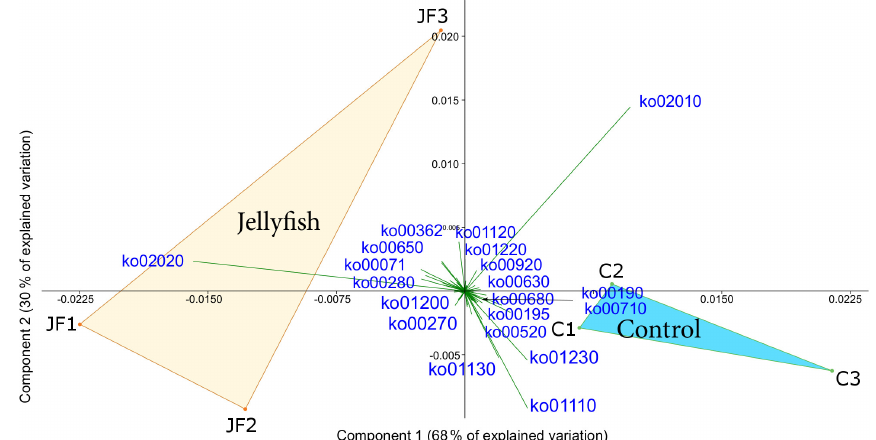
Figure 8. Principle component analysis biplot of functional diversity based on taxonomy-based functional predictions using Tax4Fun2. JF indicates jellyfish samples; C indicates control samples. The vectors present KEGG pathways. The within-group similarity is 95% between the jellyfish treatments (red) and 97% between the controls (light blue). The following KEGG pathways are shown: ko00071 – fatty